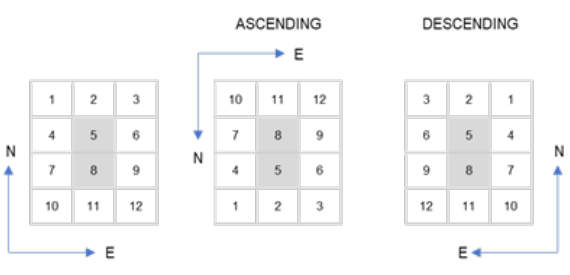
Figure 6. The windows of corner reflectors identification on ASC and DESC scenes (up-down or left-right flip of the scene) with attributed numbers corresponding to orbit direction and referenced to their “geographic” positioning (N-E) CTTC and SARScape outputs.